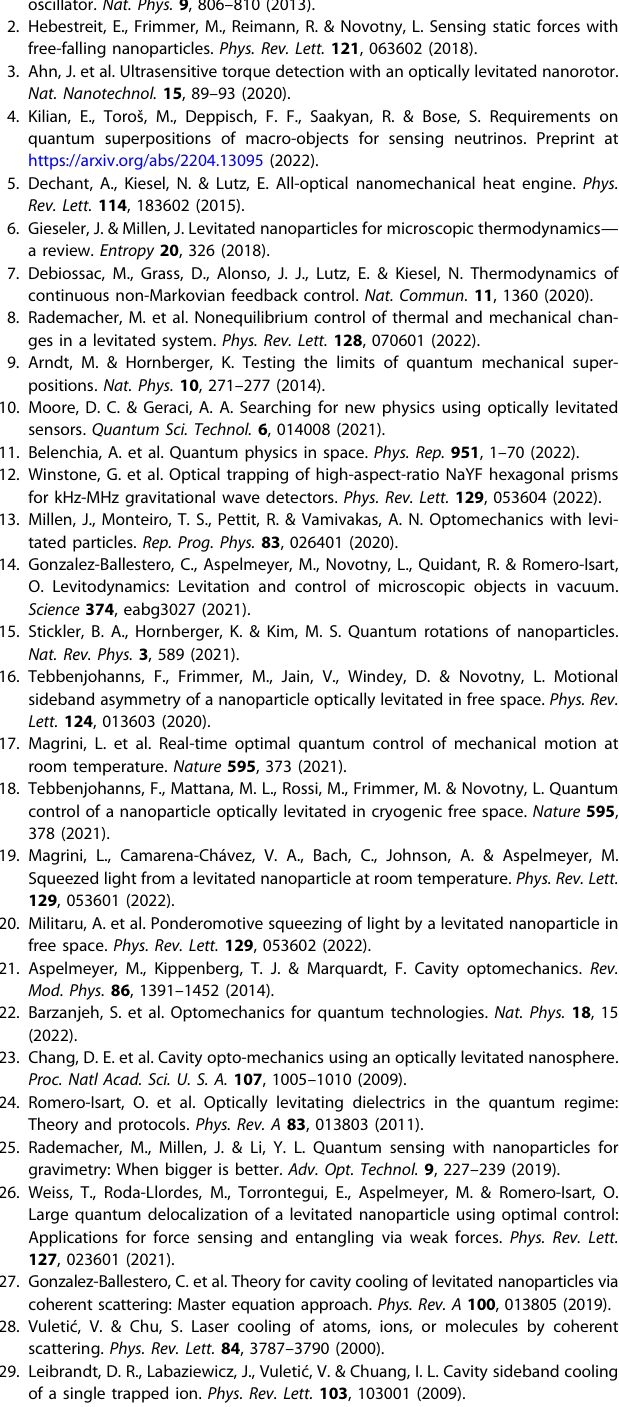
Fig. 5b. The entanglement is now distributed unequally among the three bipartitions but even the most weakly entangled bipartition (dot-dashed red line) can reach entanglement of E 3 ; max ’ 0 : 37 which surpasses the entanglement attainable for symmetric coupling.